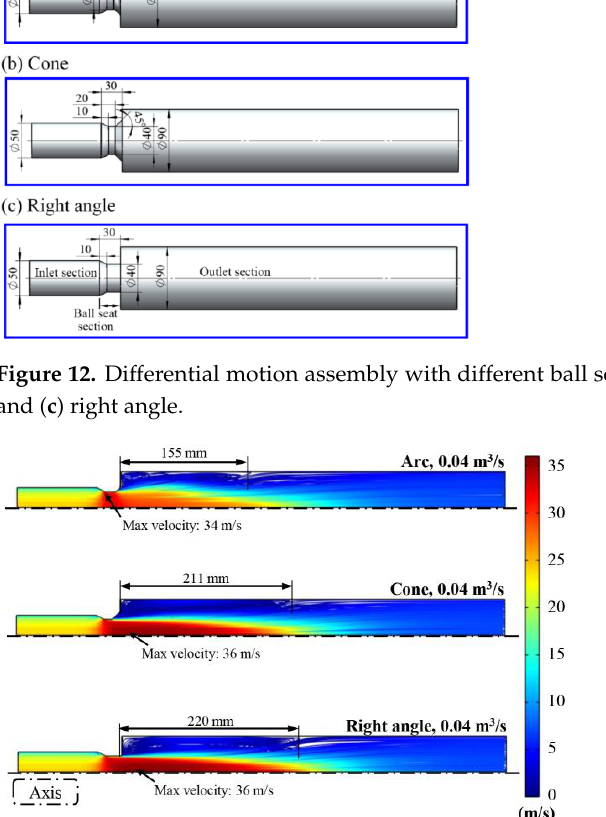
Figure 14. ( a ) Velocity distributions at the black velocity monitoring line with different diameters of the ball seat; ( b ) velocity distributions at the white velocity monitoring line with different diameters of the ball seat; the fluid viscosity was set as 100 mPa·s.